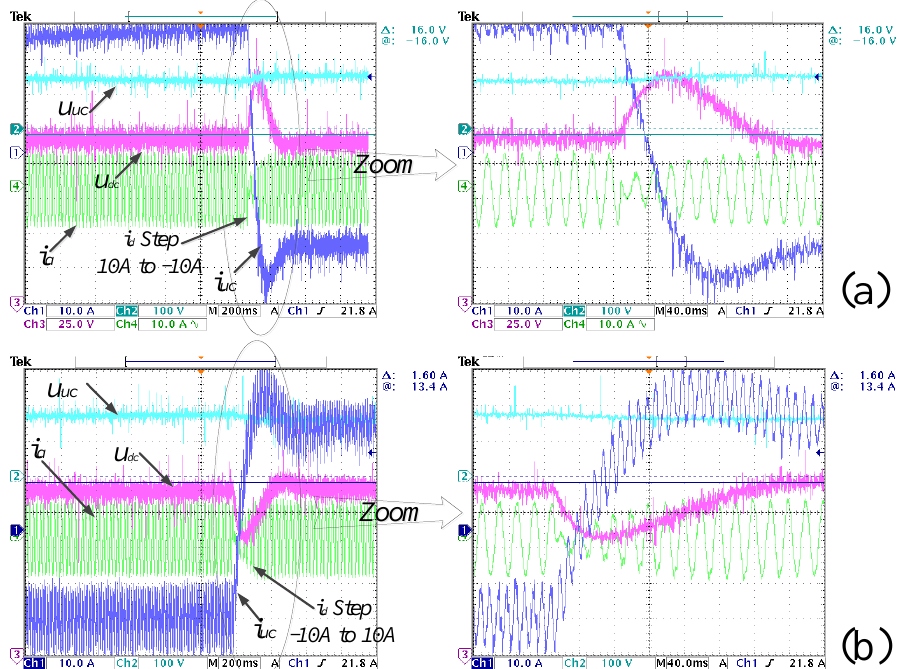
Figure 11. Dynamic waves under condition of AC load change with 150 V UC voltage: ( a ) waves of 𝑖 𝑑𝑃 step from 10 A to −10 A; ( b ) waves of 𝑖 𝑑𝑃 setp from −10 A to 10